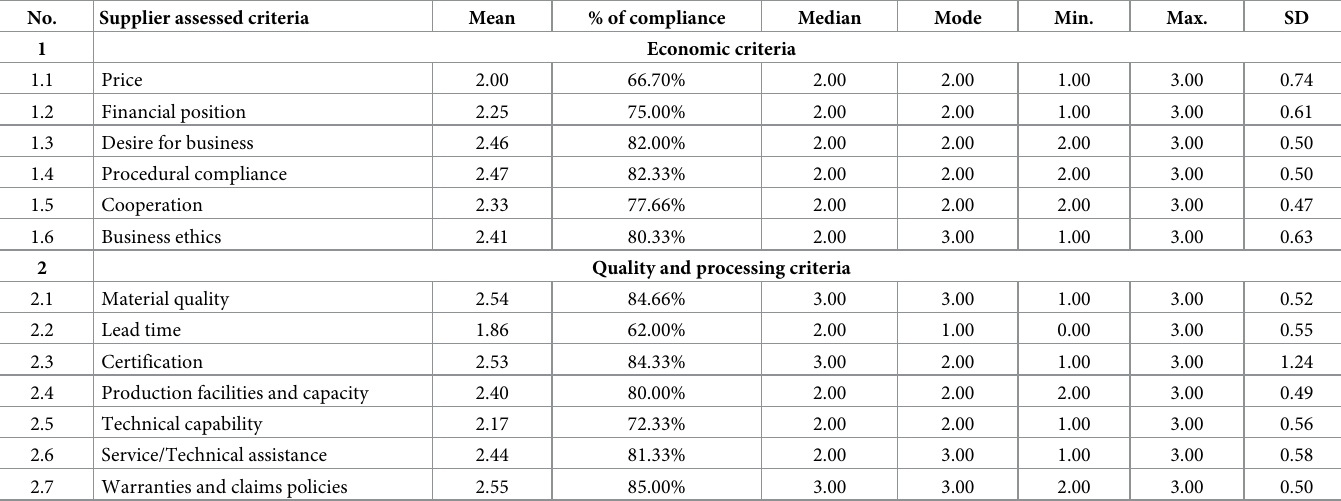
Table 2. Results of the descriptive statistics for the supplier criteria being